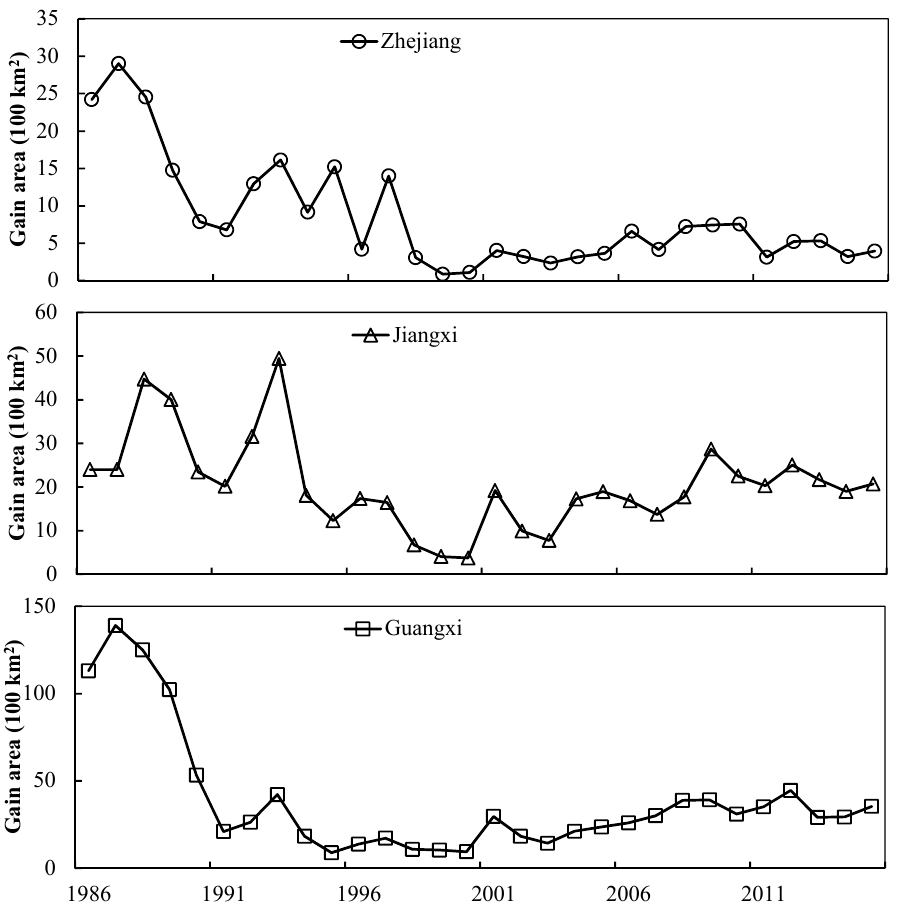
Figure 9. The interannual variations in forest gain area in the Guangxi, Jiangxi, and Zhejiang Provinces during 1986–2015.